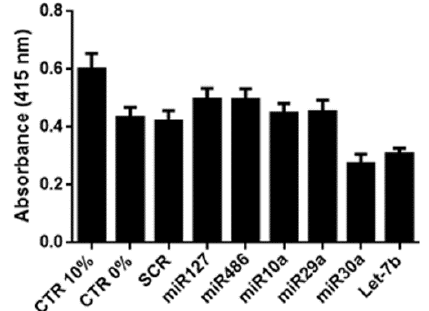
Figure 1. In vitro e ff ect of selected miRNA mimics. Di ff erent miRNA mimics (miR127, miR486, miR10a, miR29a, miR30a and let-7b-100 nM) were added to murine tubular epithelial cells (mTECs) maintained in hypoxia for 48 h, after which proliferation was evaluated following 24 h of re-oxygenation. mTECs were maintained in medium supplemented with 10% fetal calf serum (FCS) or 0% FCS, used respectively as the positive (CTR 10%) and negative (CTR 0%) controls. Data are reported as mean ± SEM for three di ff erent experiments performed in quadruplicate.